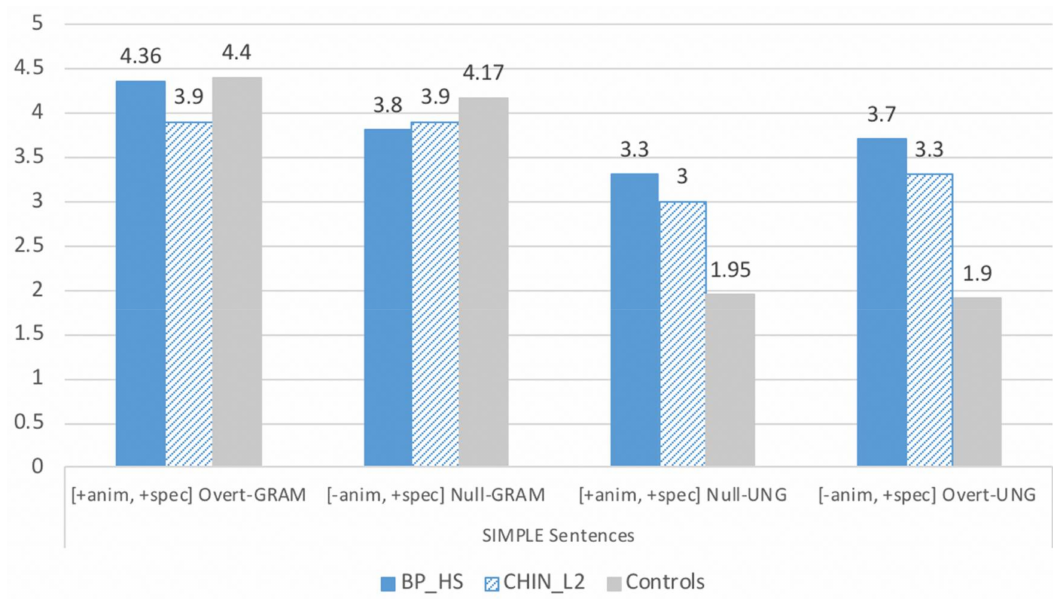
Figure 3. Acceptability judgment task (AJT): proportion of acceptance of grammatical and ungrammatical items in simple sentences per group. Overt: overt NP; Null: null object; GRAM: grammatical sentences; UNG: ungrammatical